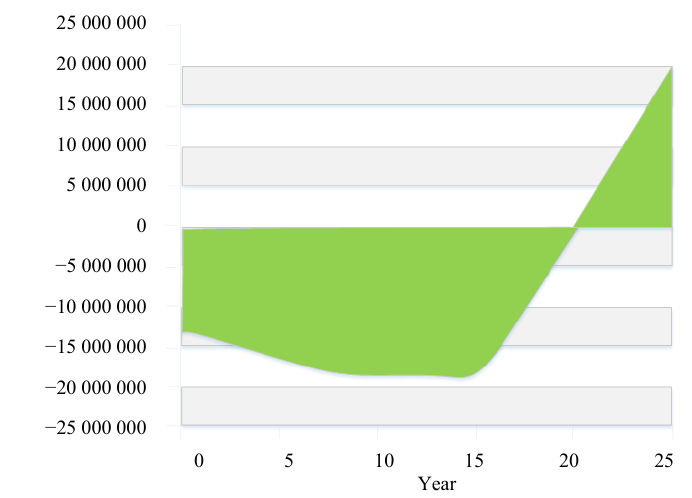
Fig. 3. Cumulative cash flow – fixed